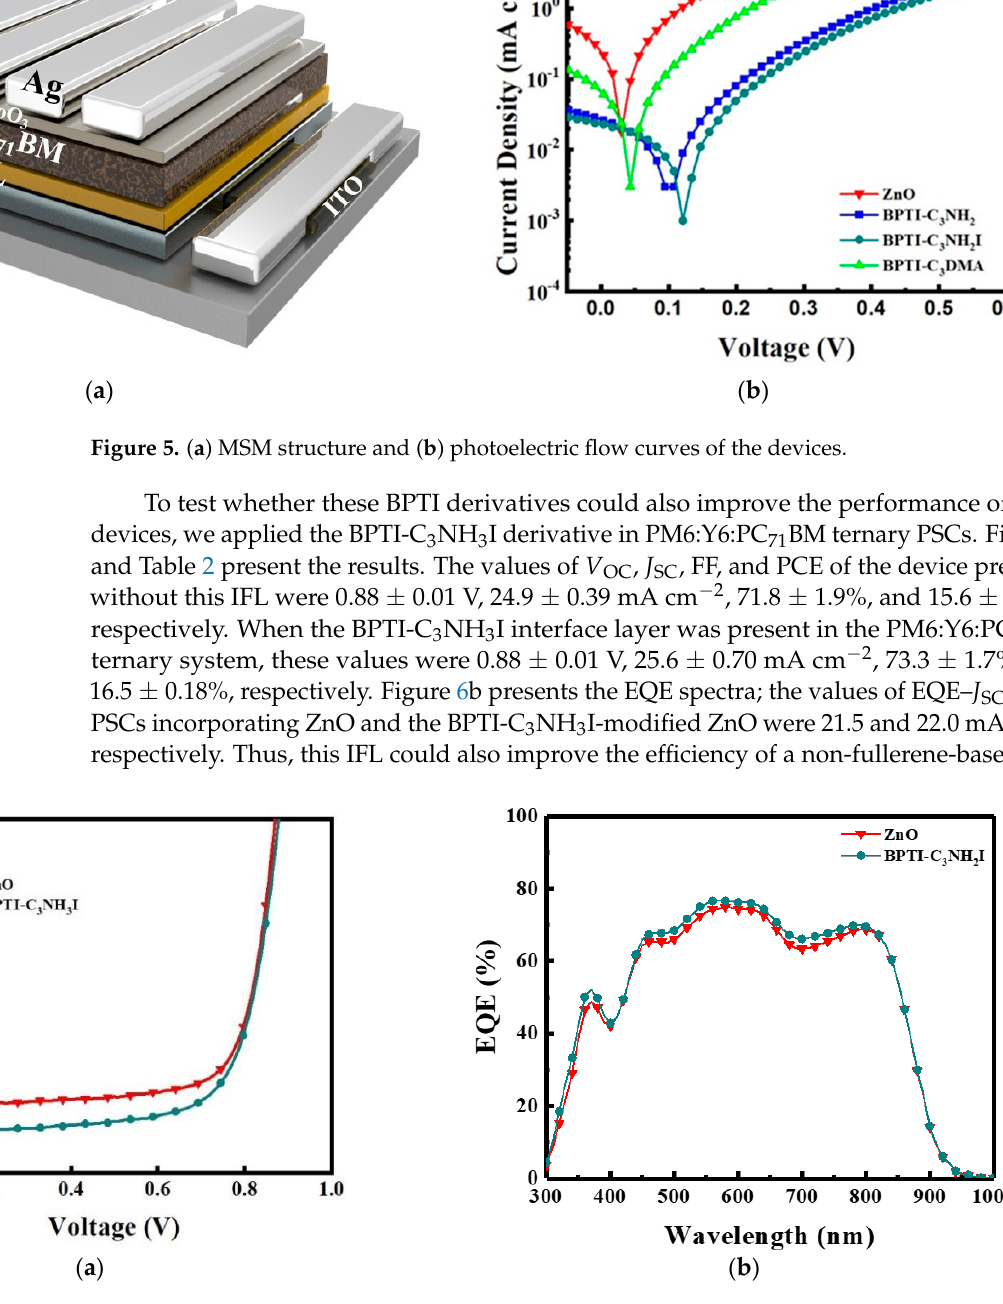
Figure 6. ( a ) J – V curves and ( b ) EQE spectra of PM6:Y6:PCBM − based PSCs.